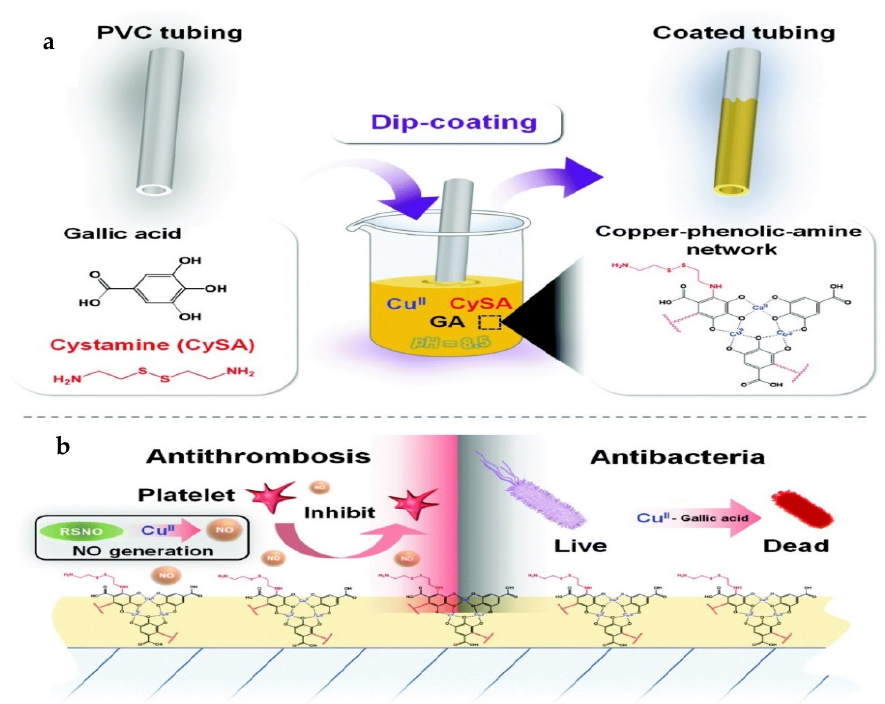
Figure 6. Scheme of the surface preparation by dual-function Cu II –GA/CySA coating reported by Tu and others [28]. ( a ) Scheme of preparation of the dual-function coating by dip-coating via metal–phenolic–amine surface chemistry; ( b ) surface coating with a copper–phenolic–amine network that can confer the PVC tubing with dual long-term antithrombotic and antibacterial